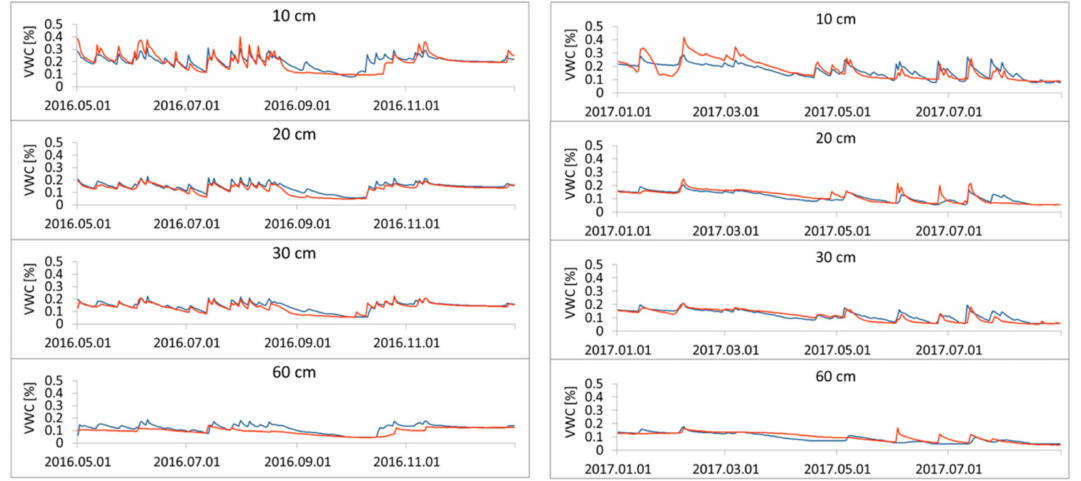
Figure 5. Comparison of the predicted and observed soil water contents (volumetric water content (VWC)) in four different soil depths in the S5 site (red line: observations, blue line: model simulations) for the calibration (left chart) and validation (right chart)